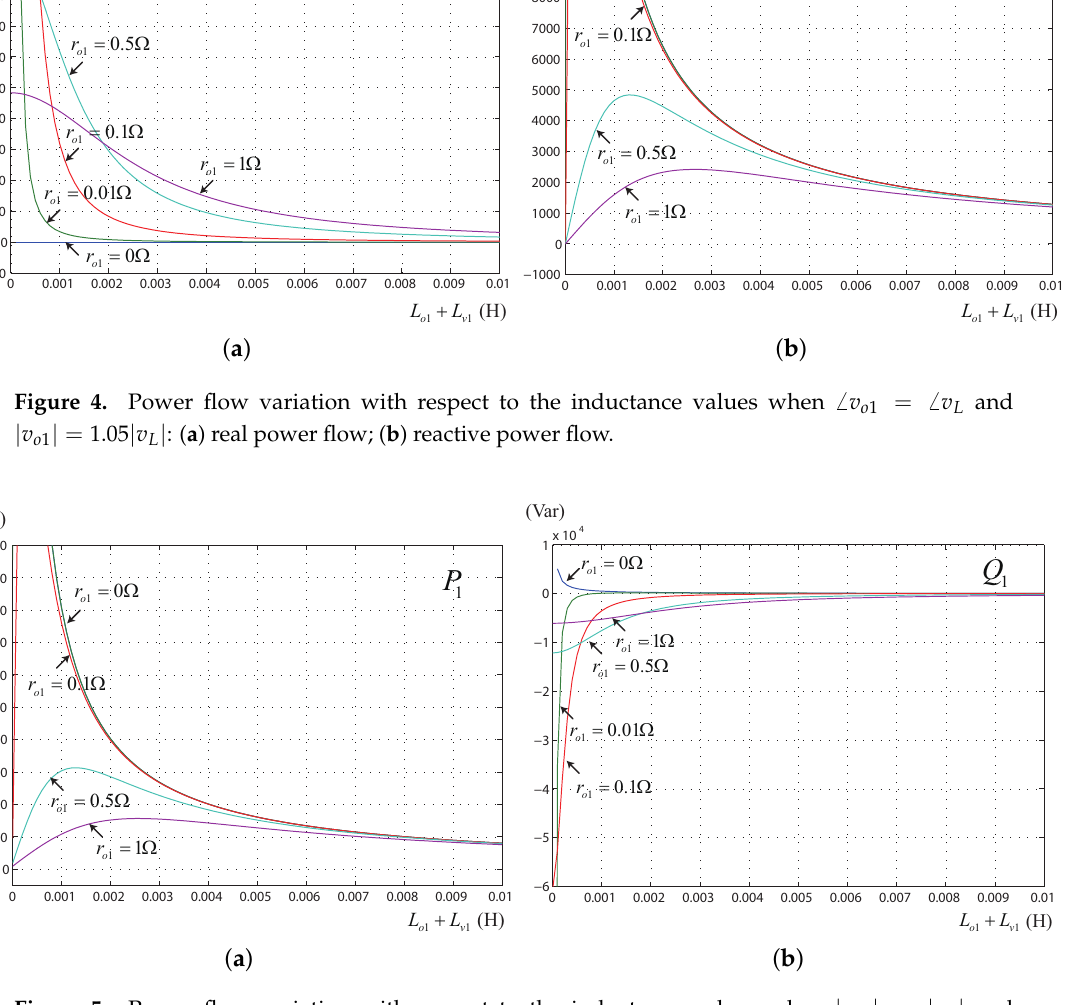
Figure 5. Power flow variation with respect to the inductance values when | v o 1 | = | v L | and (cid:54) v = (cid:54) v + 0.005 π : ( a ) real power flow; ( b ) reactive power L o 1